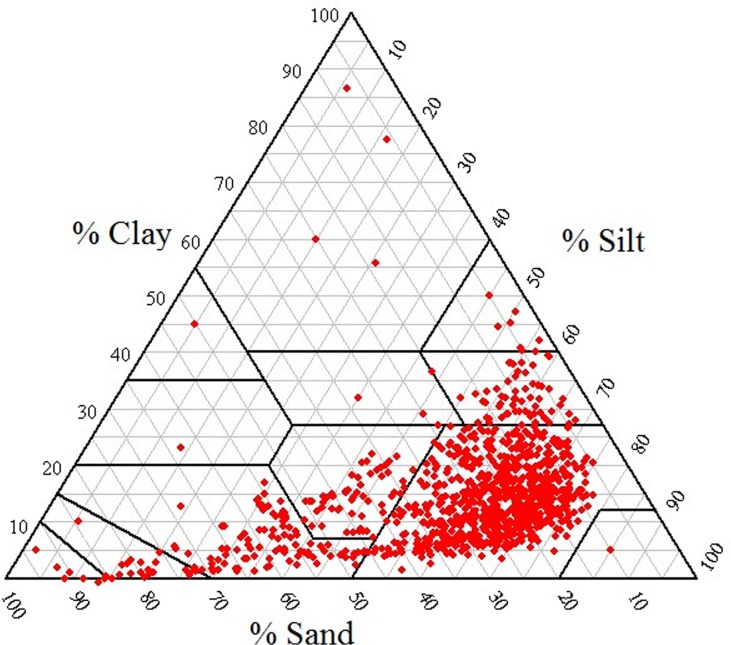
Textural composition of soil samples.